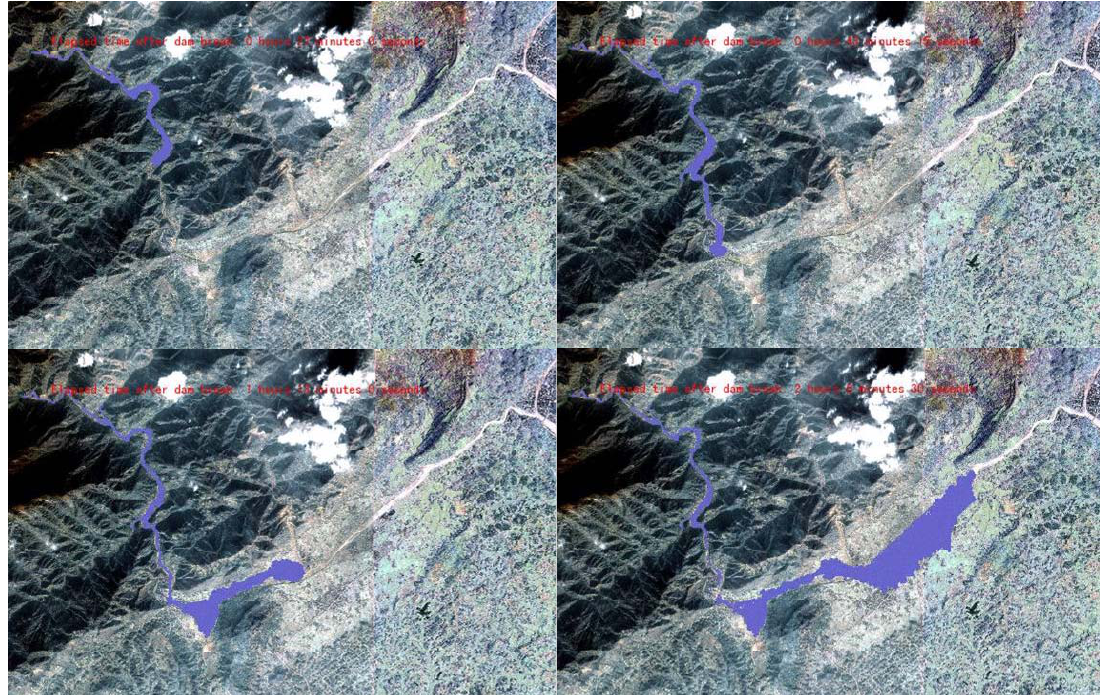
Fig. 7. Flood routing simulation results in 3-D visualization (5.19 full break).